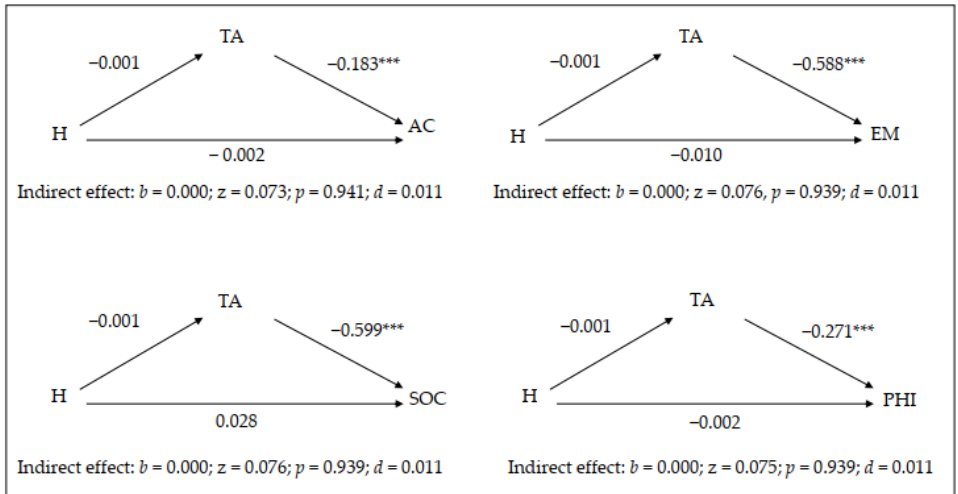
Figure 4. Graphical representation of the results of the mediation model for the hyperactivity– impulsivity symptomatology. *** p < 0.001. Table 3. Results of the mediational analysis for hyperactivity